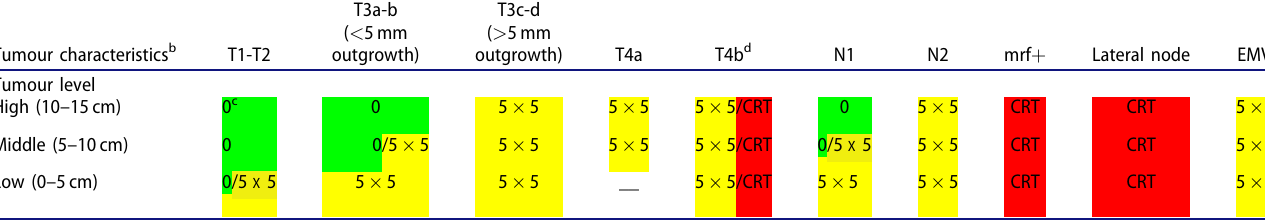
Table 1. Indications for preoperative treatment in rectal cancer according to pretreatment characteristics defined by pelvic magnetic resonance imaging. a,e